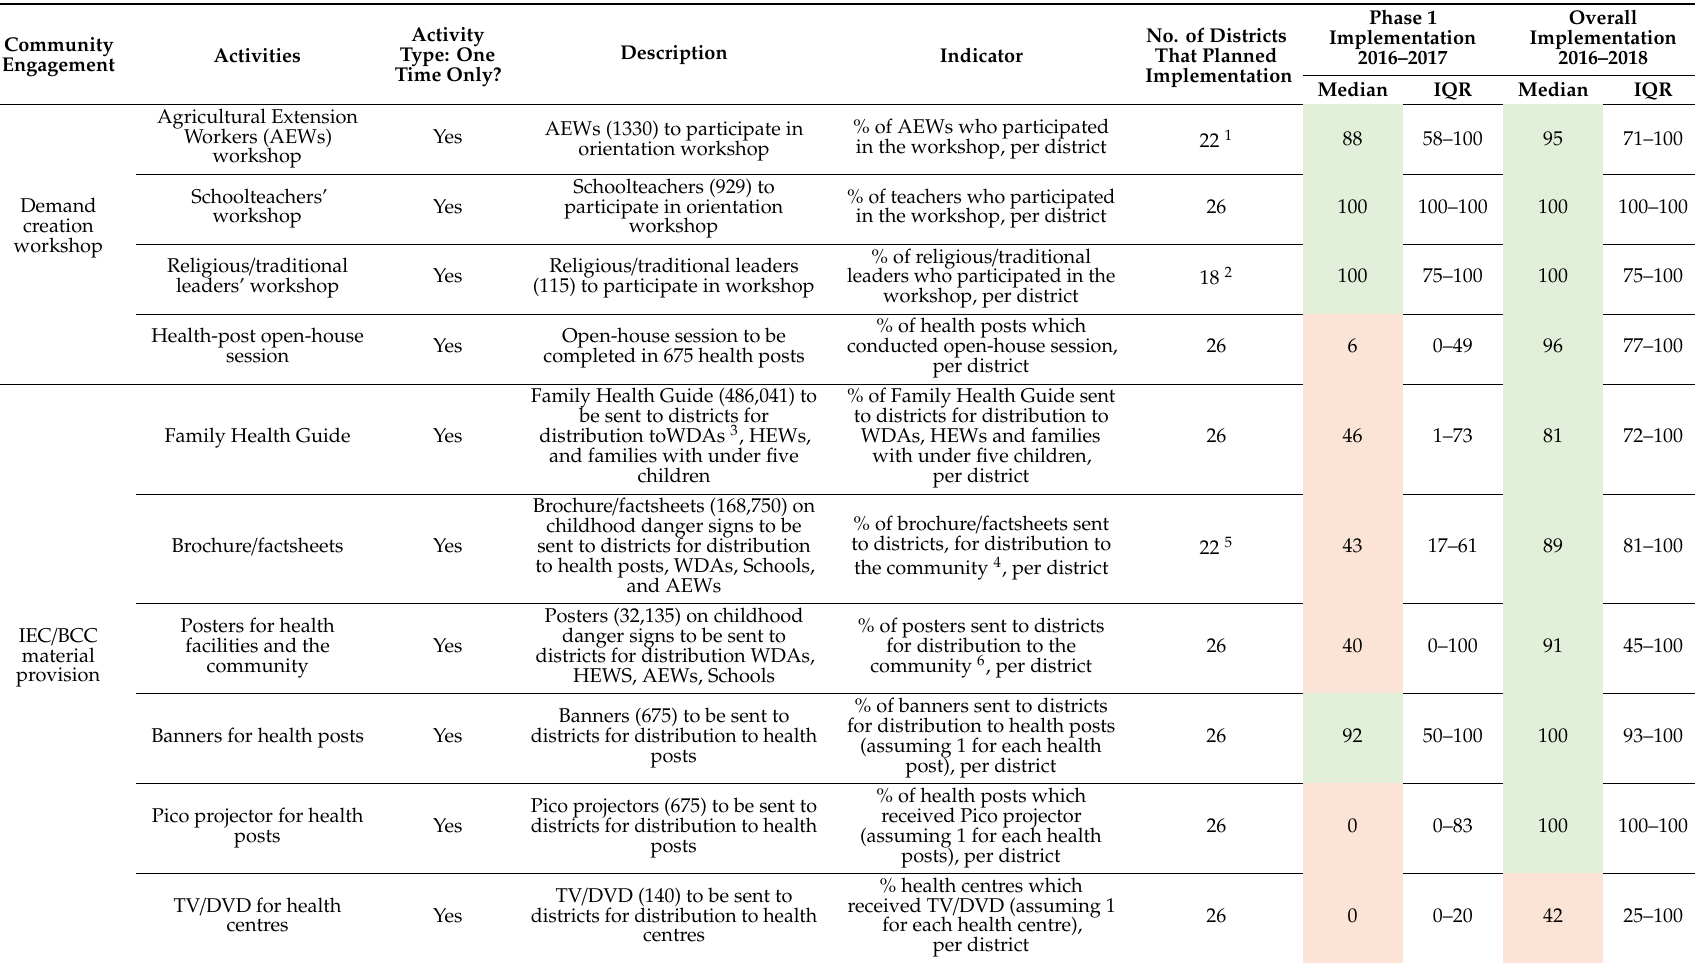
Table 1. Fidelity of implementation activities under Community Engagement Strategy in 26 districts categorised by implementation year (overall 2016–18; and restricted to 2016–17). IQR: inter-quartile range (fidelity benchmark: > 70% pale green, 50–69% pale yellow, and < 50% pale